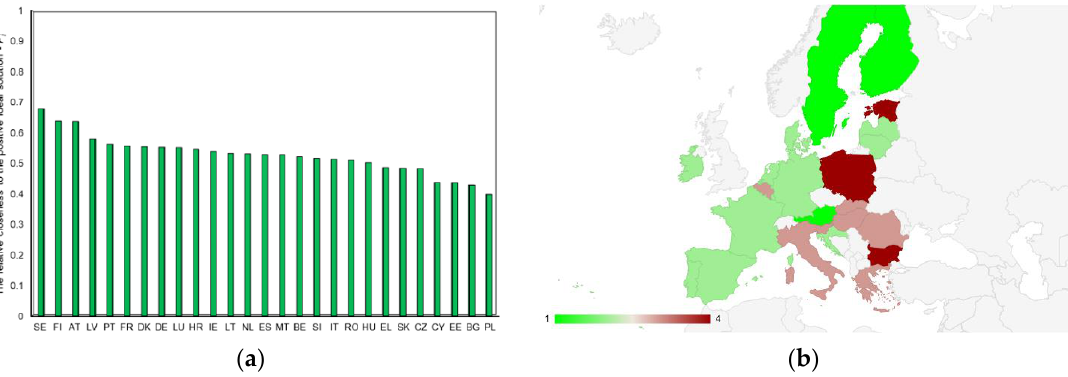
Figure 6. Ranking and level assessment of the EU-27 countries in terms of sustainable energy development, taking into account the GDP value (( a ) ranking, ( b ) level assessment). Table 4. Distance of the EU-27 countries from the ideal and non-ideal solutions together with the Technique for Order Preference by Similarity to Ideal Solution (TOPSIS) measure of sustainable energy development.